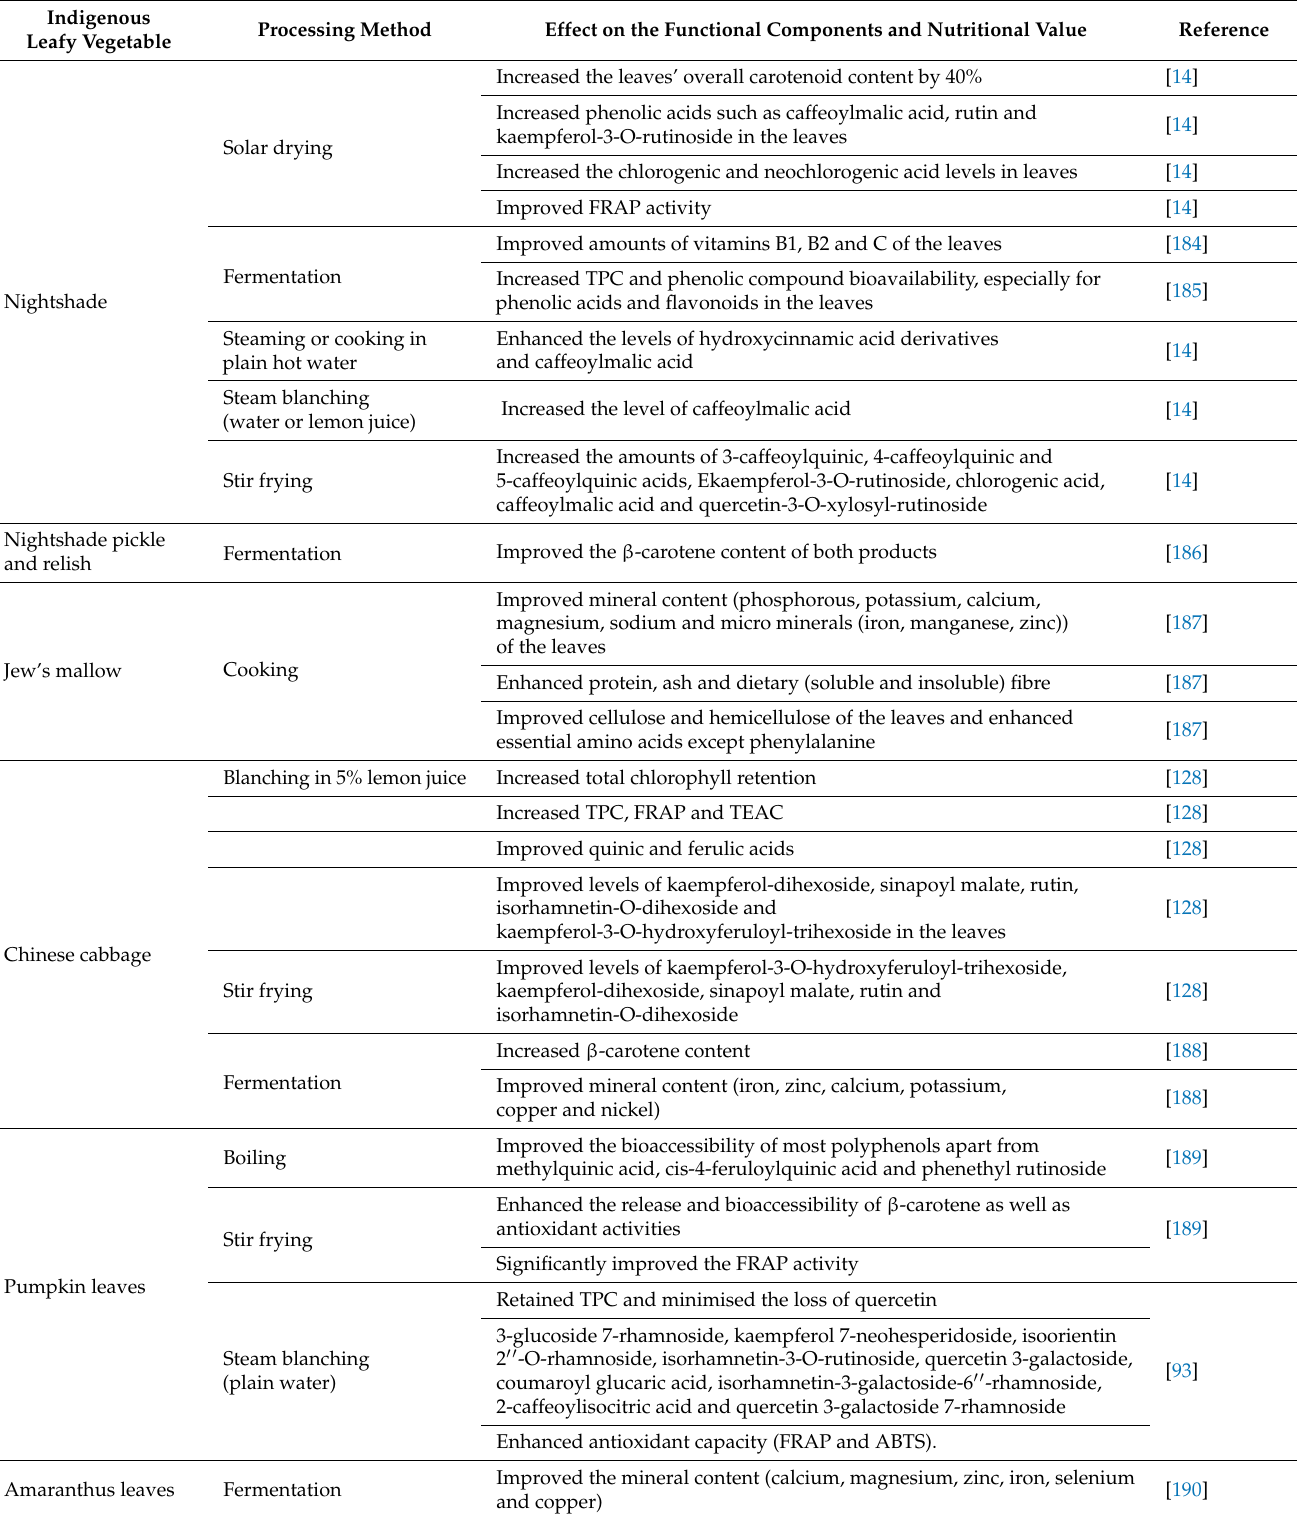
Table 4. Influence of processing methods on the functional components of indigenous leafy